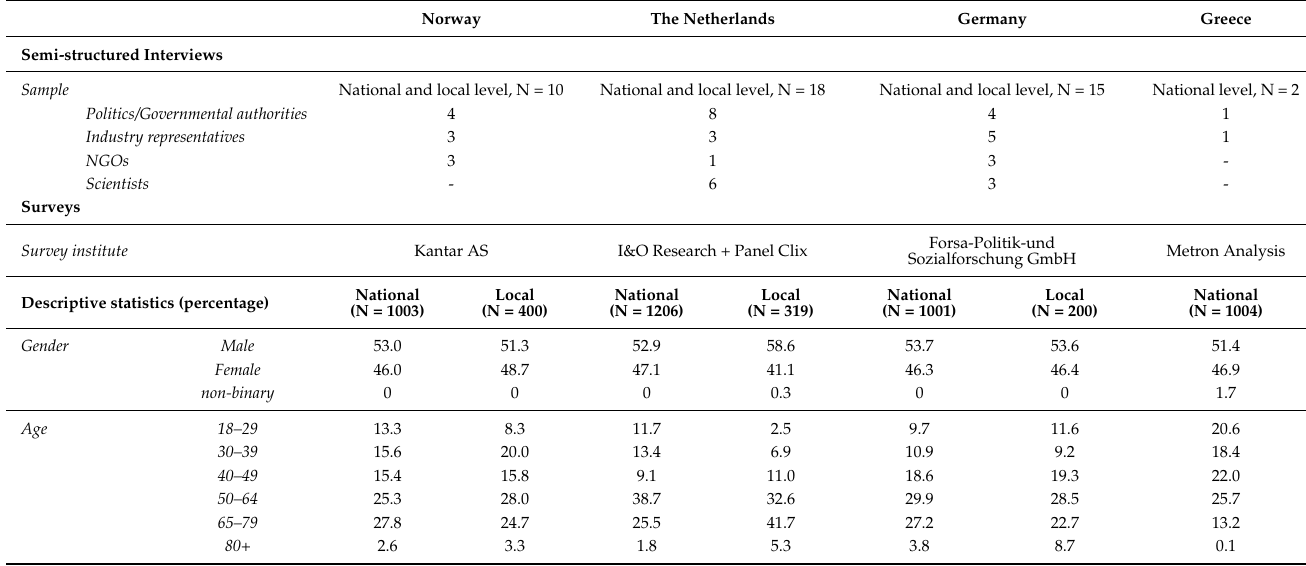
Table 2. Overview of interview and survey